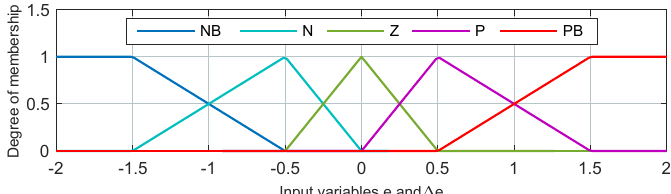
Figure 13. Membership functions for inputs e and ∆ e . Negative Big (NB), Negative (N), Zero (Z), Positive (P), and Positive Big (PB).